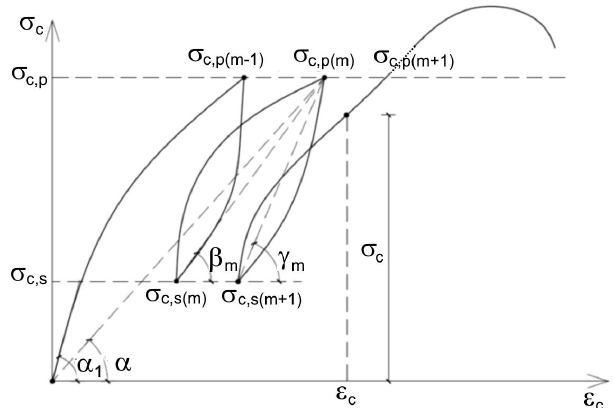
Figure 3. Graph of tension–deformation dependence for lightweight concrete ( LWC) under multiple loadings.